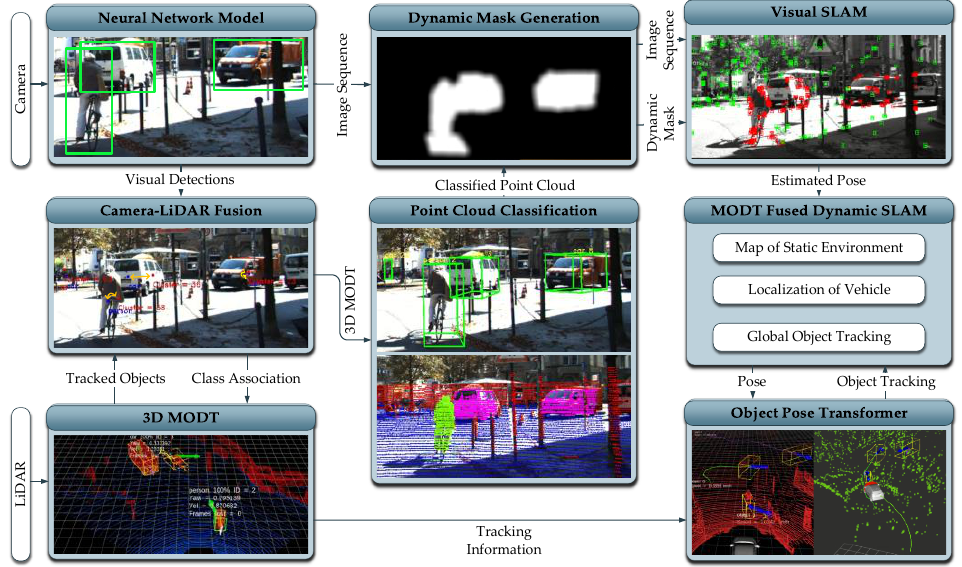
Figure 2. Proposed MODT integrated Dynamic SLAM framework.